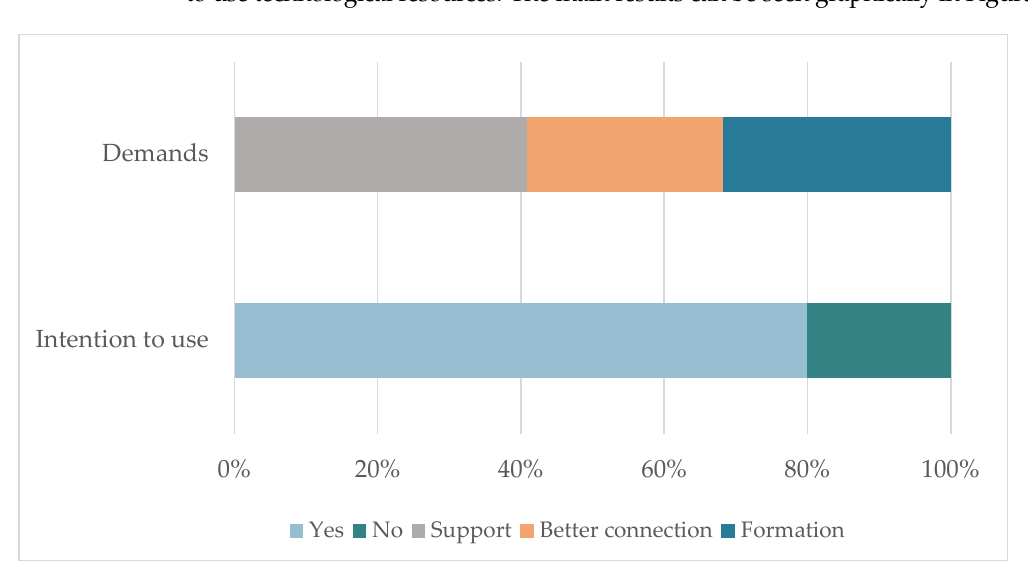
Figure 5. Main results for the expectation of their future use of technology.